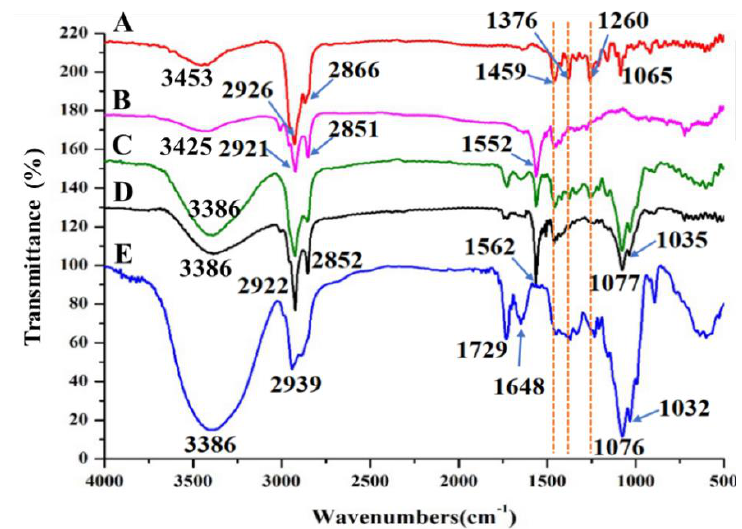
Figure 4. FTIR spectra of individual ingredients and their complex samples: (A) α -tocopherol, (B) NaOl, (C) simple physical mixture of α -tocopherol, NaOl, and RebA, (D) α -TOC-NaOl/RebA complex, and (E) RebA.